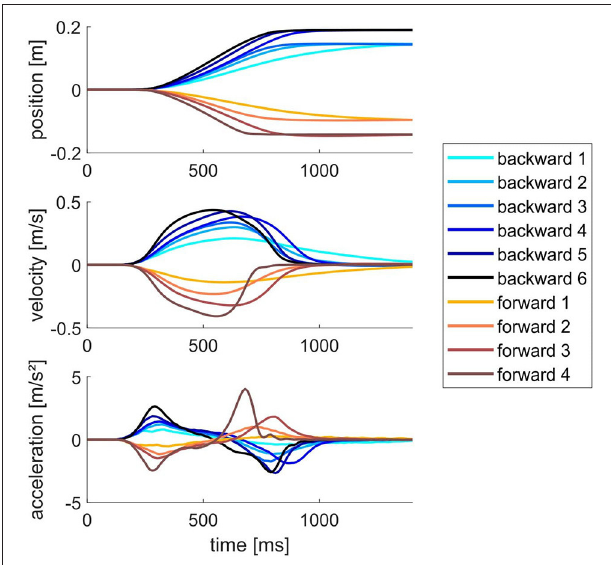
FIGURE 2 | Position, velocity and acceleration profiles of the platform for the six backward and four forward support-surface